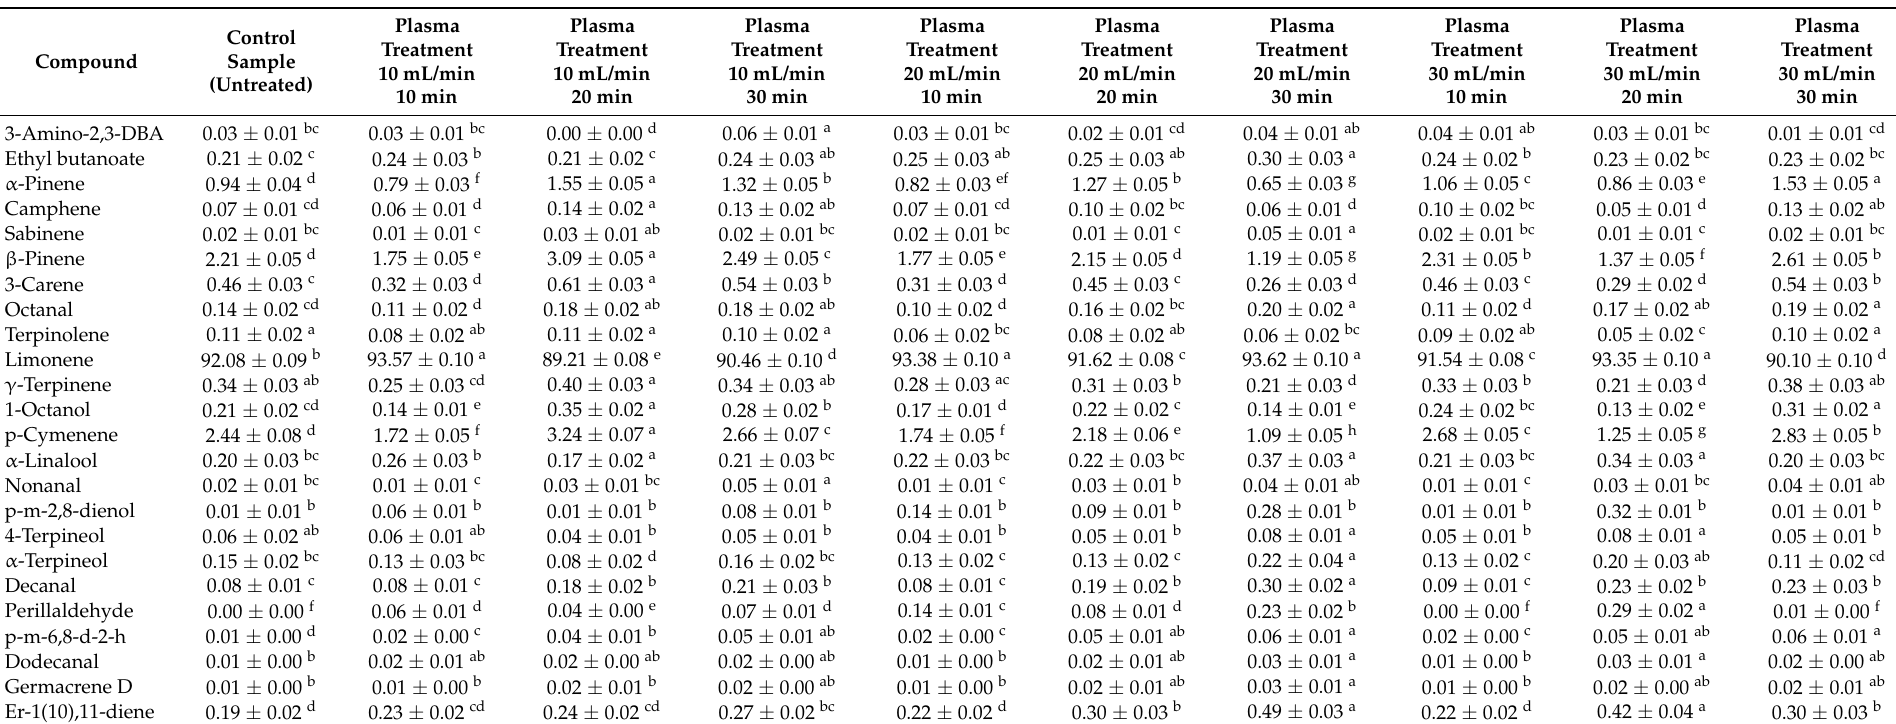
Table 2. Mass fraction of the volatile compounds identified in orange juice in the control sample and plasma-treated samples. Same letters (a–h) indicate statistically similar values at a 95% confidence